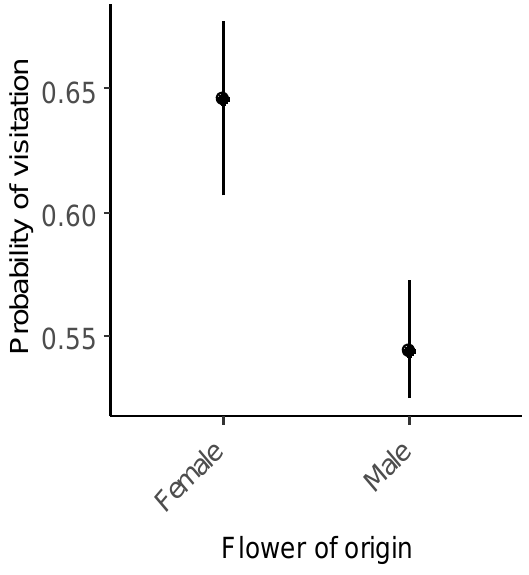
Figure 4. The effect of flower of origin on the probability of visitation to a female flower by a leafcutter bee ( N = 229) or honey bee ( N = 275) ( P < 0.001). Points represent the model-adjusted means and lines represent the 95% CI.